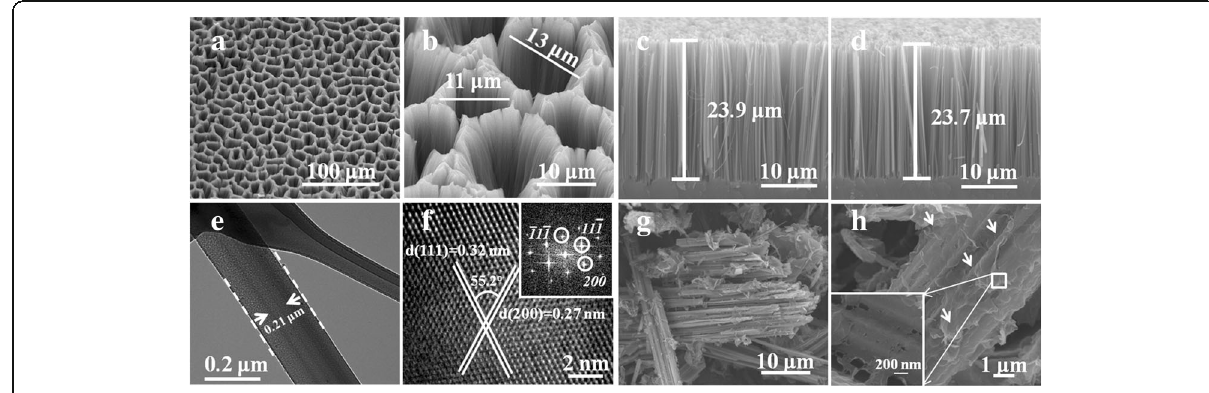
Fig. 1 a Top view, b zoomed-in top view, and c cross-sectional SEM images of n-SiNWs. d Cross-sectional SEM image of p-SiNWs. e TEM image of n-SiNWs. f HRTEM image of n-SiNWs together with the corresponding FFT. g SEM image of RGO@n-SiNWs with HF treatment. h Zoomed-in SEM image of RGO@n-SiNWs with HF